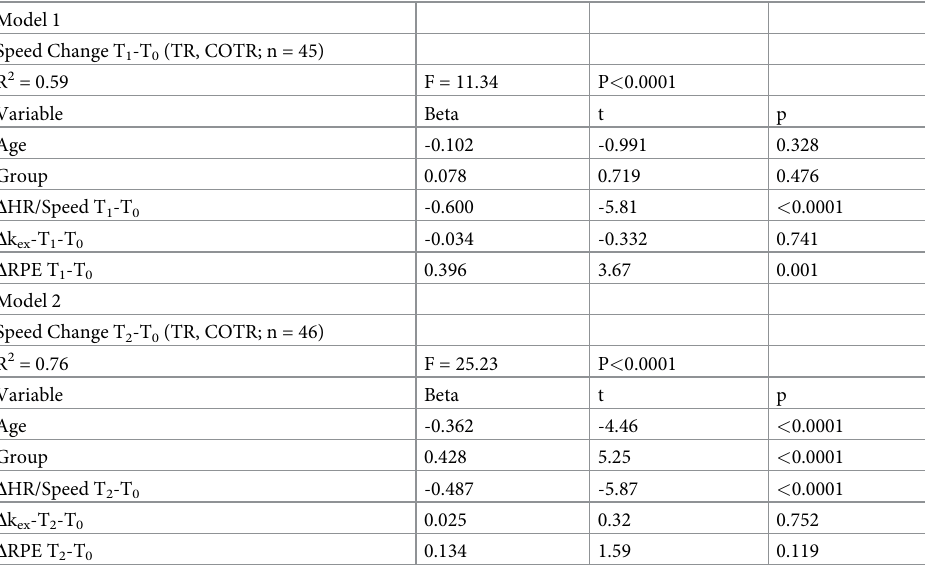
Table 4. Multiple regression analysis of self-selected speed